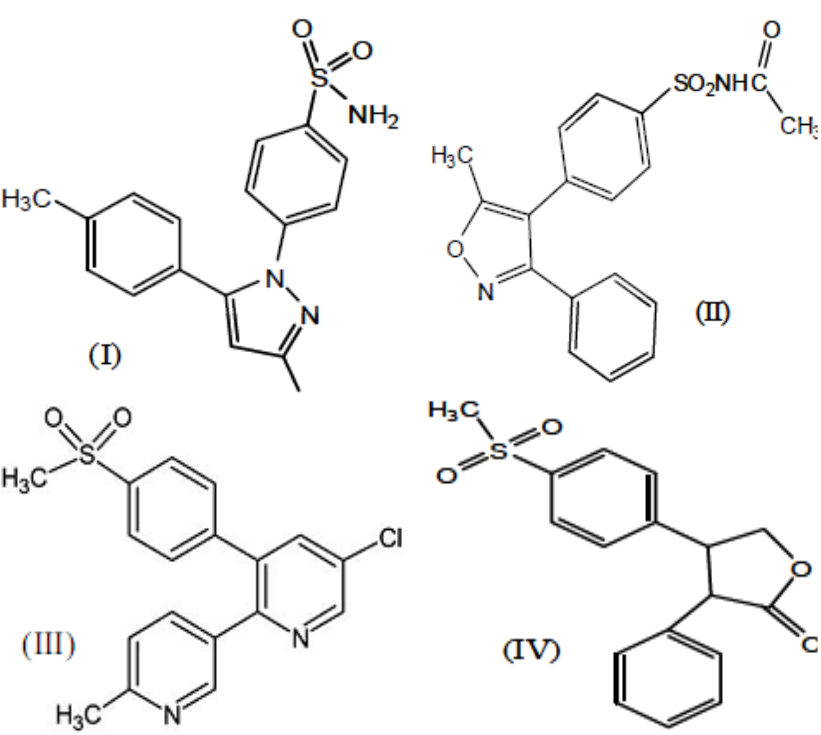
Figure 1. Common selected COX-2